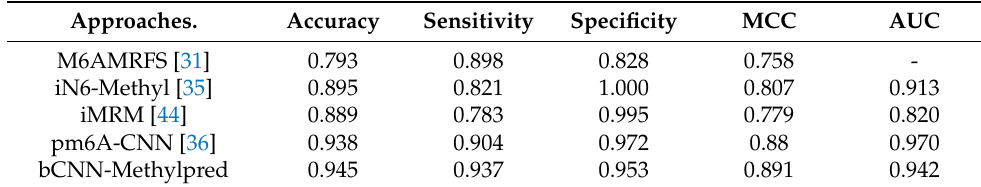
Table 8. Comparison of m6A site prediction using proposed and state-of-the-art approaches based on M. musculus species.